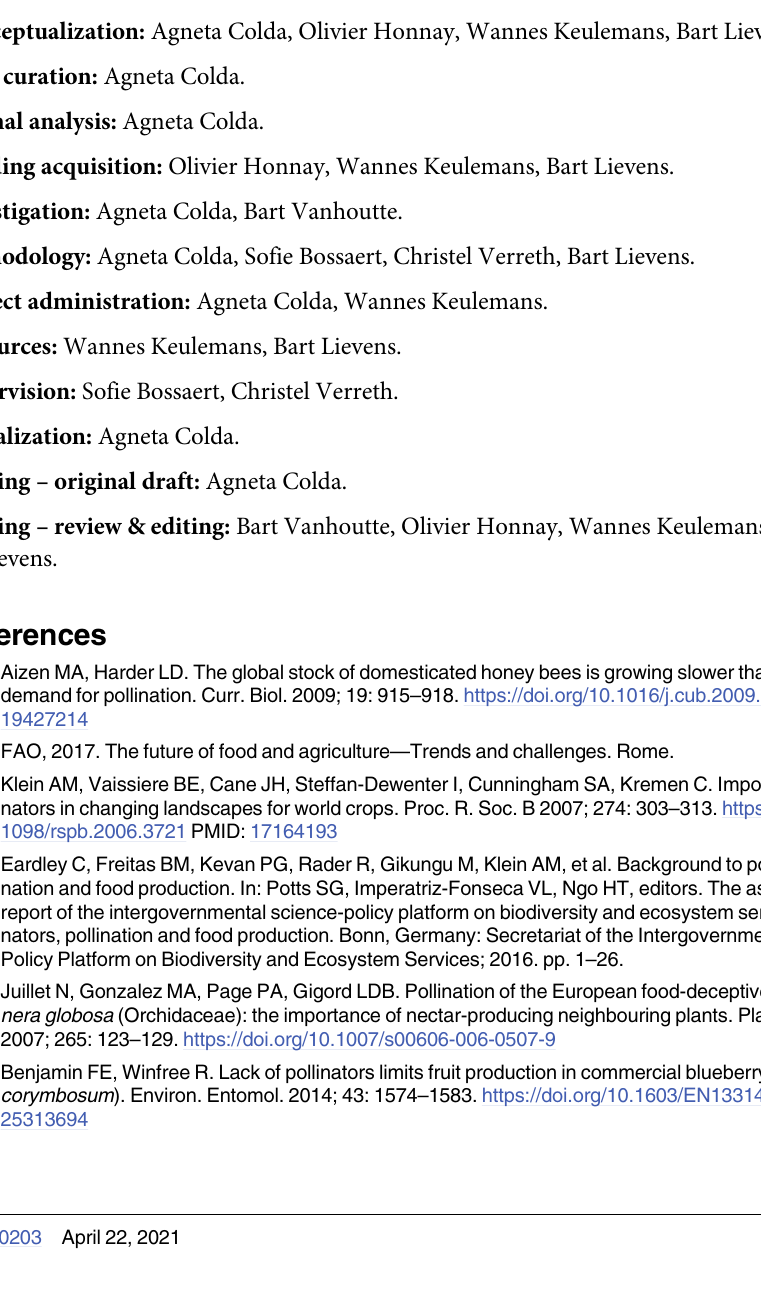
S2 Dataset. Initial amount of clusters and fruit set data of supplementary hand pollination experiment in the orchard of Tielt-Winge. S3 Dataset. All data sets supporting the results in the results section of this paper.